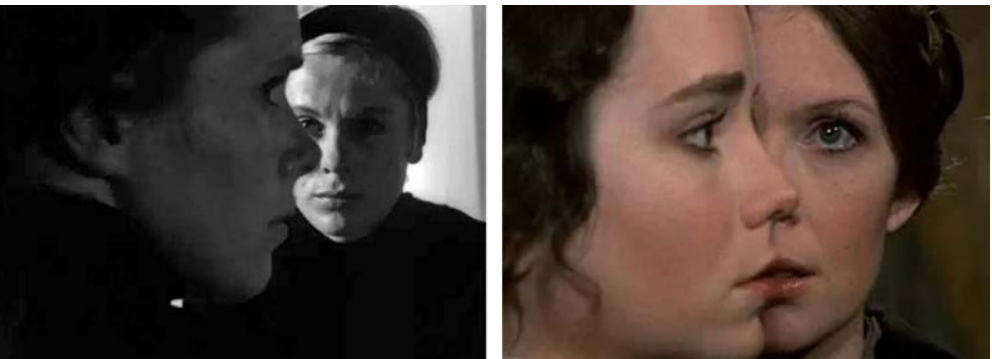
Fig. 8 Ingmar Bergman, Persona , 1966 (left); Woody Allen, Love and Death , 1975